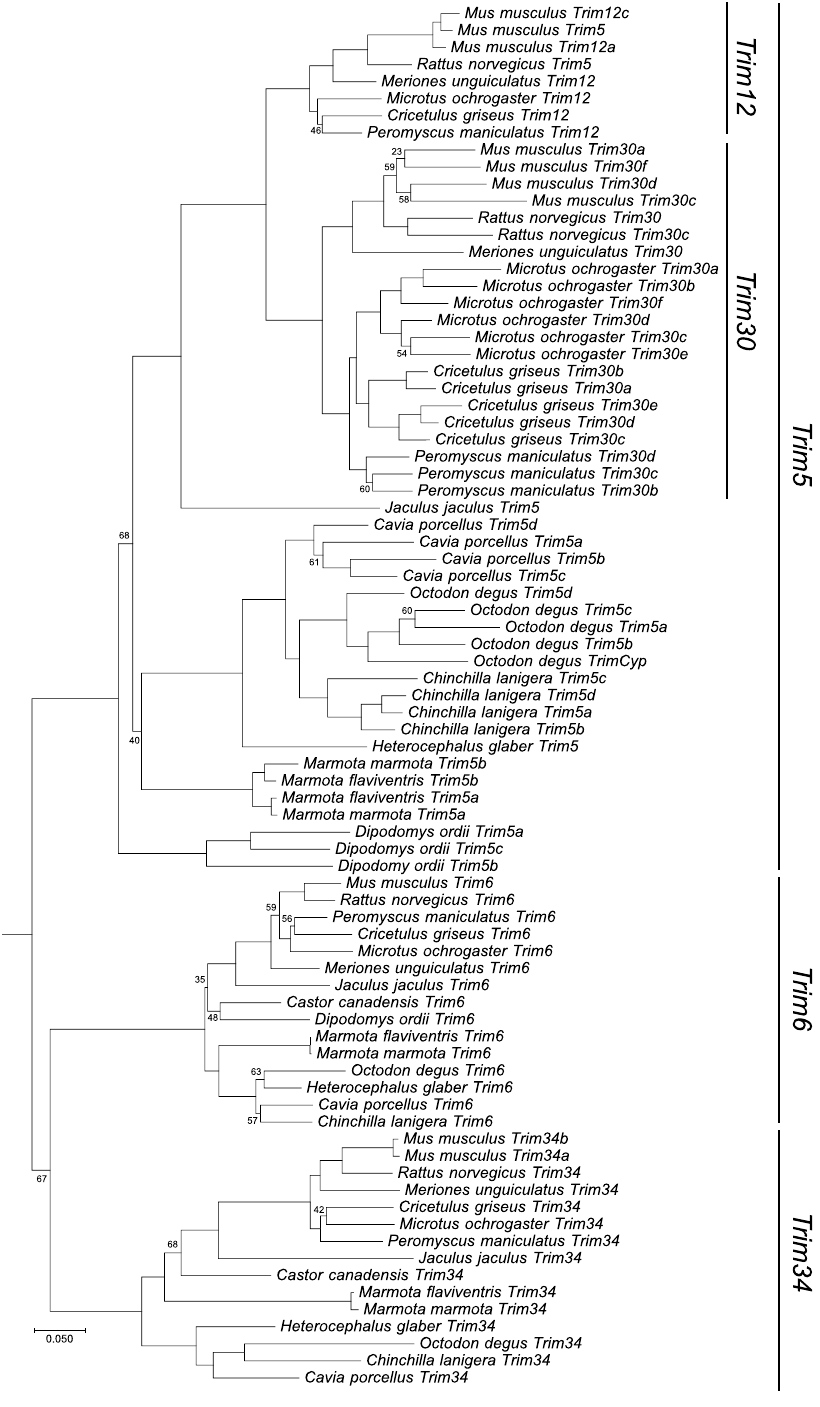
Figure 2. Phylogeny of the rodent Trim5 , Trim6 and Trim34 R-B-CC domains. Open reading frames (ORFs) coding for the R-B-CC domains of annotated Trim clade of genes in the Trim5 cluster of selected rodents were aligned and maximum likelihood trees were generated using RAxML with 500 replicates. Bootstrap values that are below 70 are shown at the relevant nodes. The tree was rooted with Human TRIM22 . Phylogenetic grouping of each gene clade is indicated to the right of the